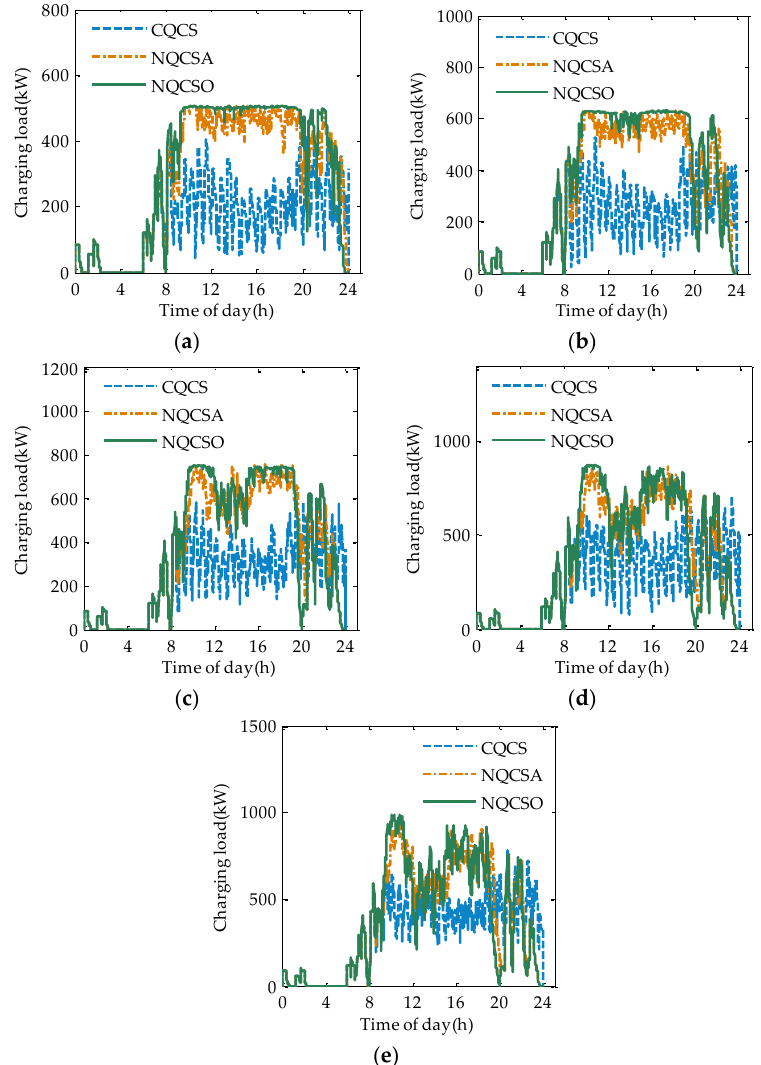
Figure 12. Charging load of a CS with different numbers of chargers during the simulation period in different charging conditions: ( a ) four chargers; ( b ) five chargers; ( c ) six chargers; ( d ) seven chargers; ( e ) eight chargers.